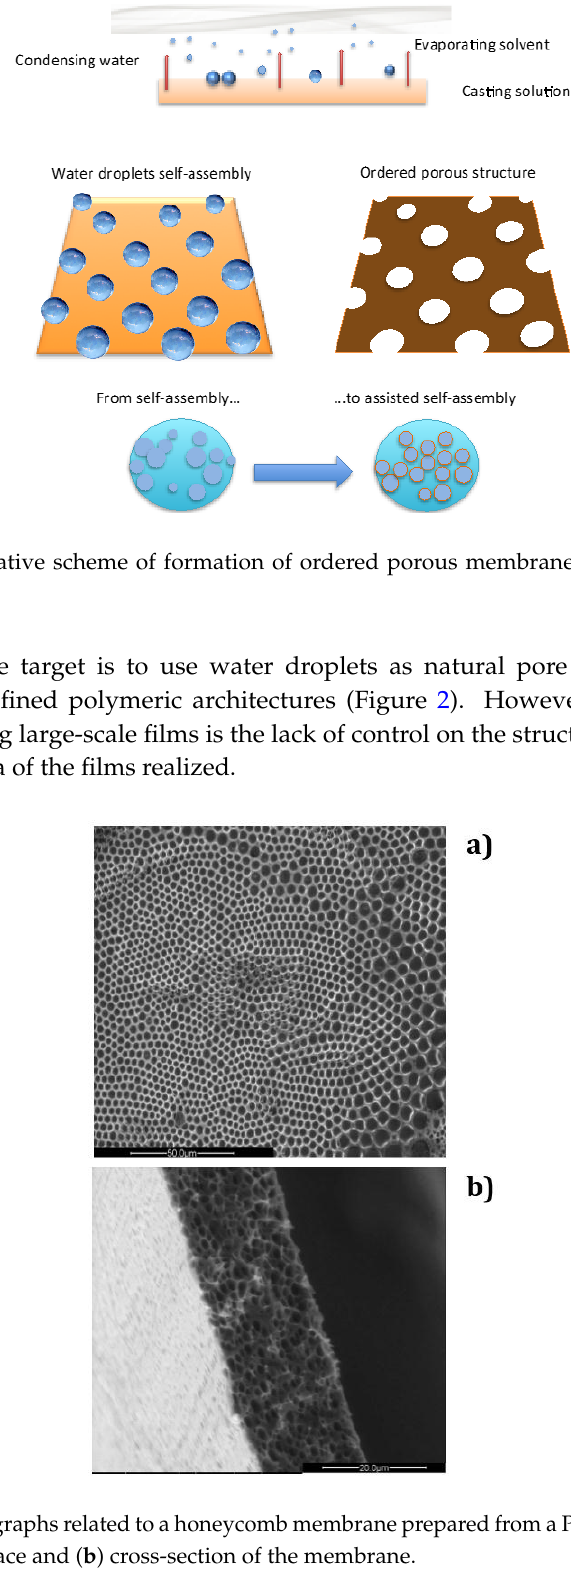
Figure 2. SEM micrographs related to a honeycomb membrane prepared from a PSU/DCM/2-propanol solution: ( a ) top surface and ( b ) cross-section of the membrane. solution: ( a ) top surface and ( b ) cross-section of the